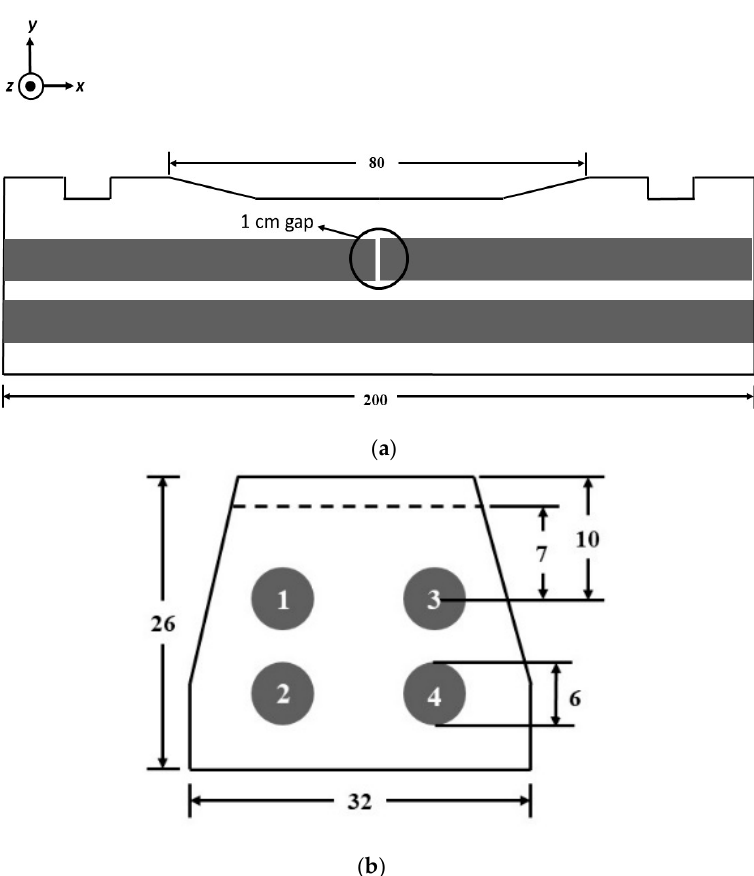
Figure 4. ( a ) Side view of the concrete specimen. ( b ) Top view of the concrete specimen. Only steel rebar 1 is measured. (All units are in centimeters).